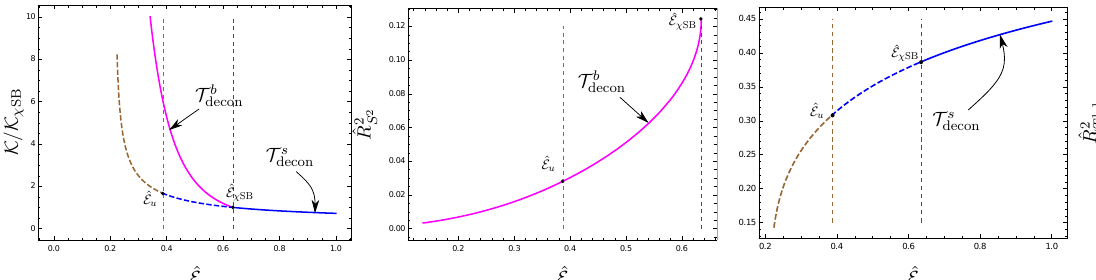
(5.7) of the holographic geometries dual K b . The small ˆ growth of ˆ of decon K χ SB E K T s states decon T